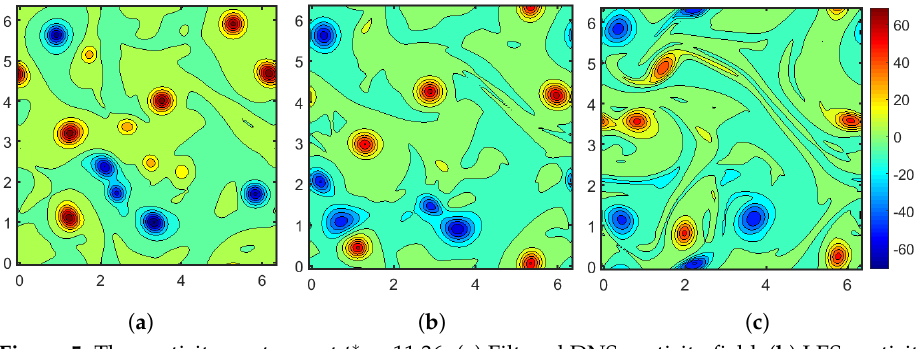
Figure 5. The vorticity contours at t ∗ = 11.36. ( a ) Filtered DNS vorticity field; ( b ) LES vorticity field with NN models; ( c ) Vorticity field on coarse grid with no